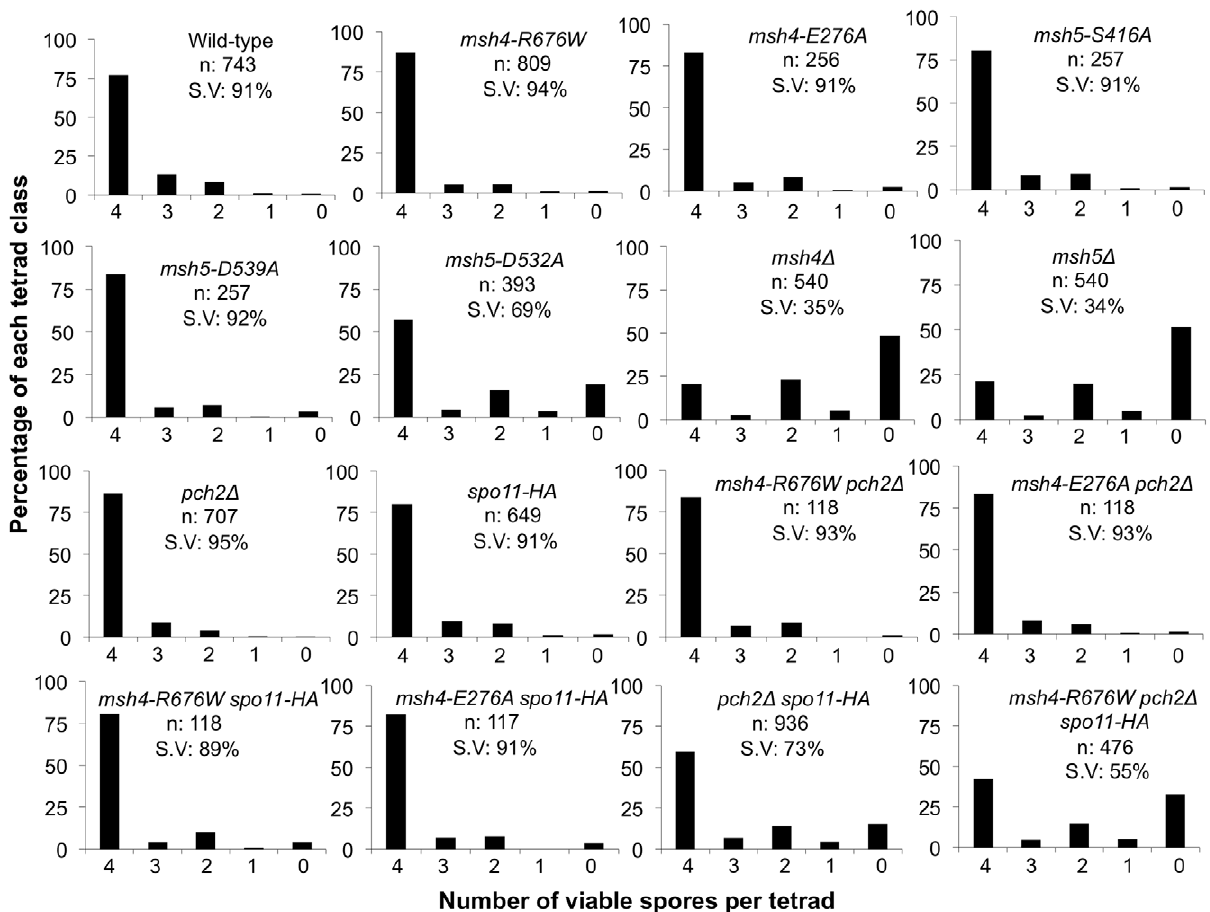
Figure 4. Spore viability profile of wild-type and mutant strains in the NHY942/943 strain background. The vertical axis shows the percentage of each tetrad class and the horizontal axis represents the number of viable spores in a tetrad. n: total number of tetrads dissected, SV: percentage spore viability. Data for wild-type, pch2 D , spo11-HA and pch2 D spo11-HA are from Zanders and Alani [21].